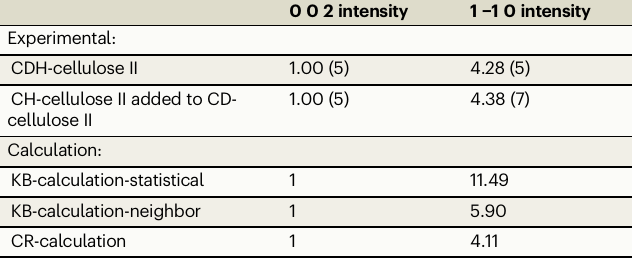
Table 1 | Relative observed and calculated intensities of peaks (0 0 2) and (1 − 1 0) from the neutron fi ber diffraction patterns of cellulose II, normalized so that (0 0 2) is the